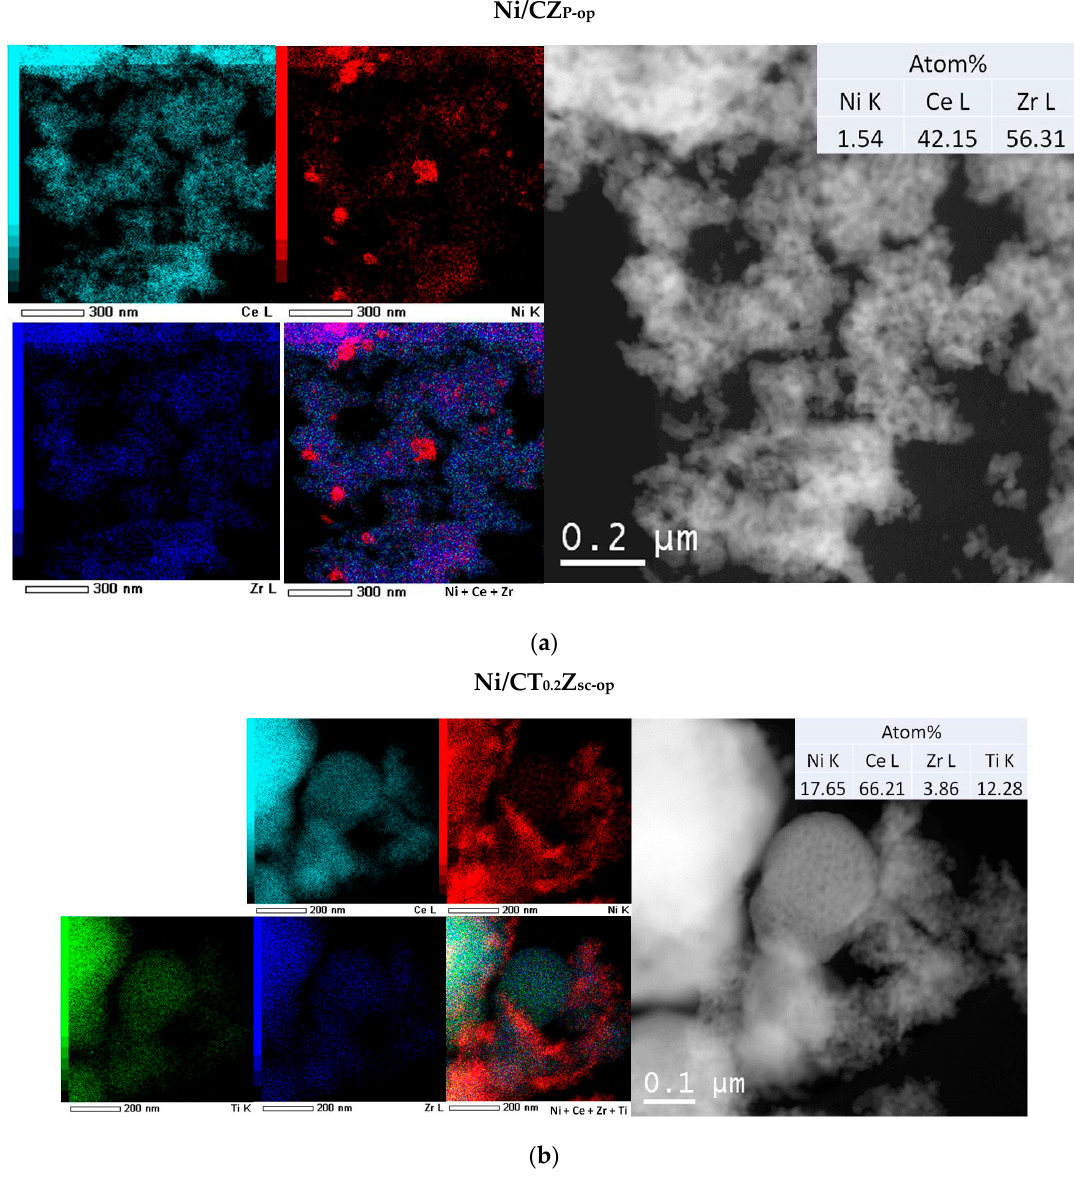
Figure 11. HAADF-STEM images with EDX analysis of the fresh one-pot 5% Ni/Ce 0.75 Zr 0.25 O 2 prepared using the Pechini route ( a ) and 5% Ni/Ce 0.75 Ti 0.2 Zr 0.05 O 2- δ prepared using supercritical synthesis ( b ).